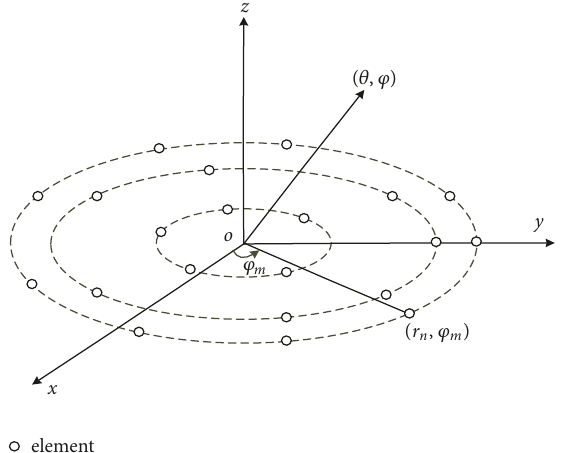
Figure 1: Diagram of concentric ring